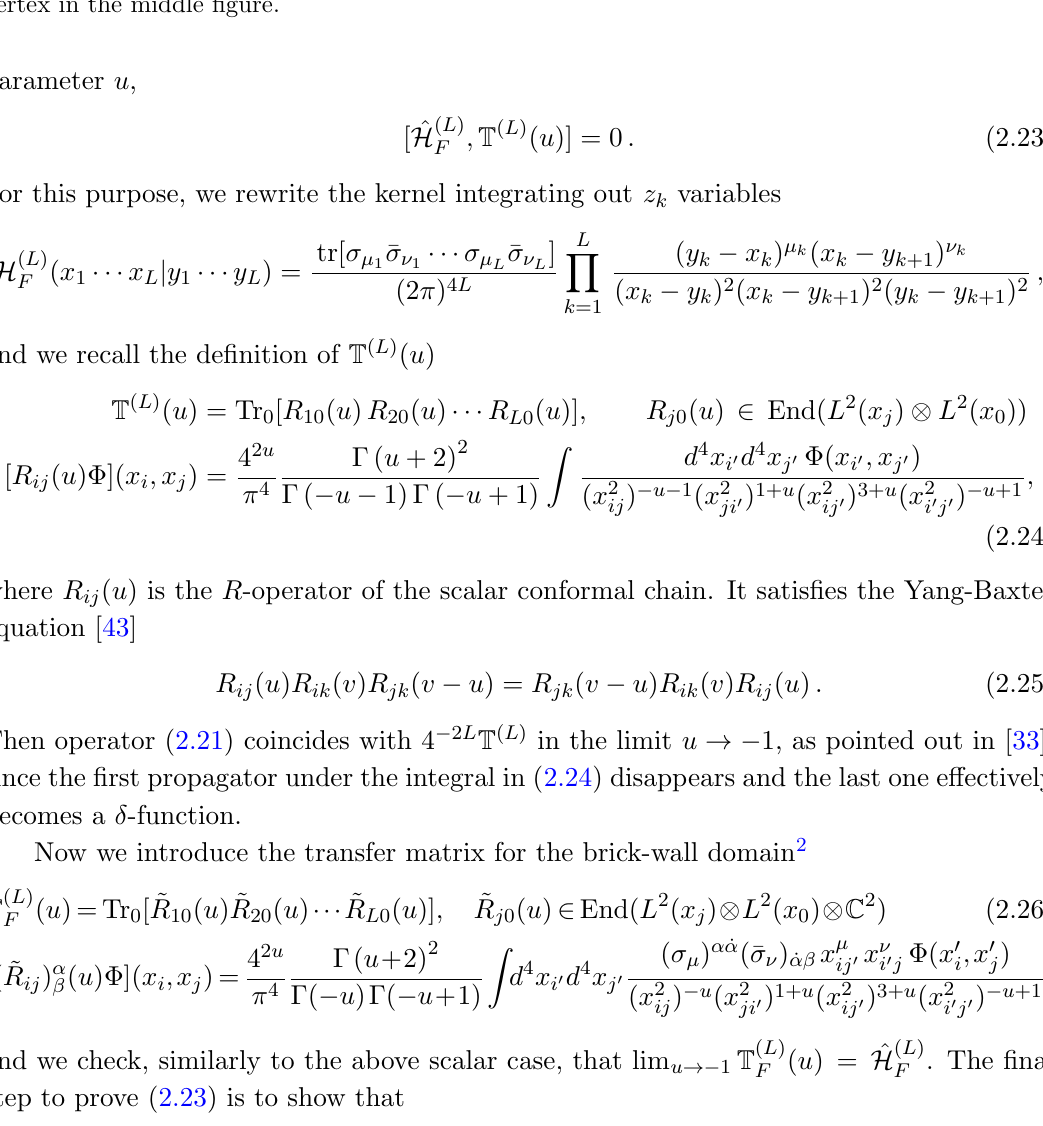
Figure 7 . Proof of the commutation relation [ ^ H ( L ) ; ^ H ( L ) ] = 0 at L = 3. Gray blobs are external B F coordinates, black dots are integration points and we denoted lines which coincide due to periodic b.c. with blue. Left: ^ H ( L ) H ( L ) ( x 1 ; x 2 ; x 3 j y 1 ; y 2 ; y 3 ). In the middle: the result of integration over B F Yukawa vertices. Right: ^ H ( L ) H ( L ) ( x 1 ; x 2 ; x 3 j y 1 ; y 2 ; y 3 ) as result of opening triangles with single y j F B vertex in the middle